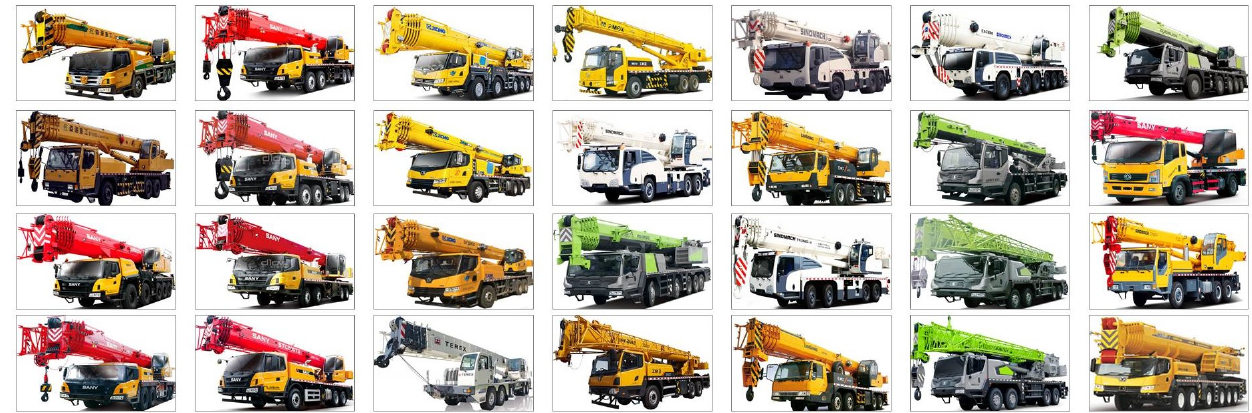
Figure 3. Partial sample pictures.